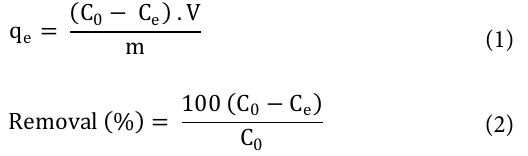
, TiO -Gly, and TiO 2 2